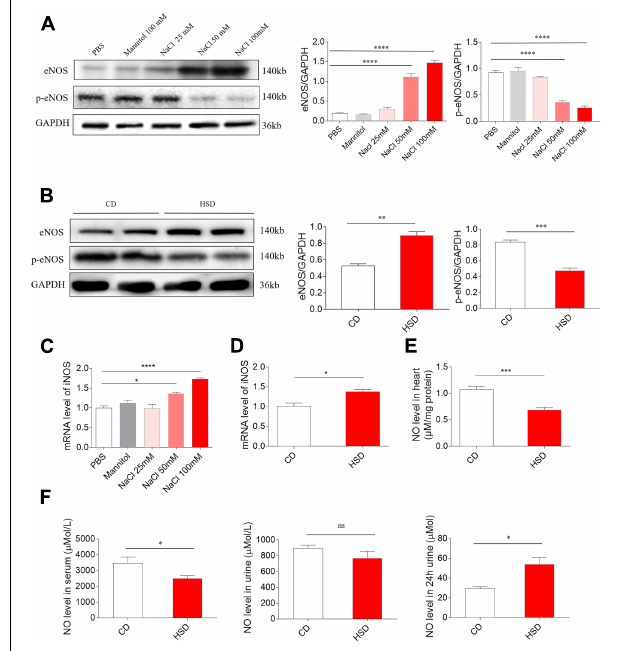
FIGURE 4 | Levels of endothelial nitric oxide synthase (eNOS), p-eNOS, inducible NOS (iNOS), and nitric oxide (NO). (A) The level of eNOS was higher, but p-eNOS was lower in H9C2 cells treated with middle (50 mM) and high (100 mM) doses of sodium chloride (NaCl). (B) The expression of eNOS was increased, but p-eNOS was reduced in the heart of high-salt diet (HSD) rats with hypertension-resistant (HR). (C) The level of iNOS was higher in H9C2 cells treated with middle (50 mM) and high (100 mM) doses of NaCl. (D) The level of iNOS was increased in the heart of HSD rats with HR. (E) NO level was reduced in the heart of HSD rats with HR. (F) NO level was reduced in the serum, but was increased in the 24-h urine of HSD rats with HR. The results are expressed as mean ± SEM. * p < 0.05, ** p < 0.01, *** p < 0.001, and **** p <